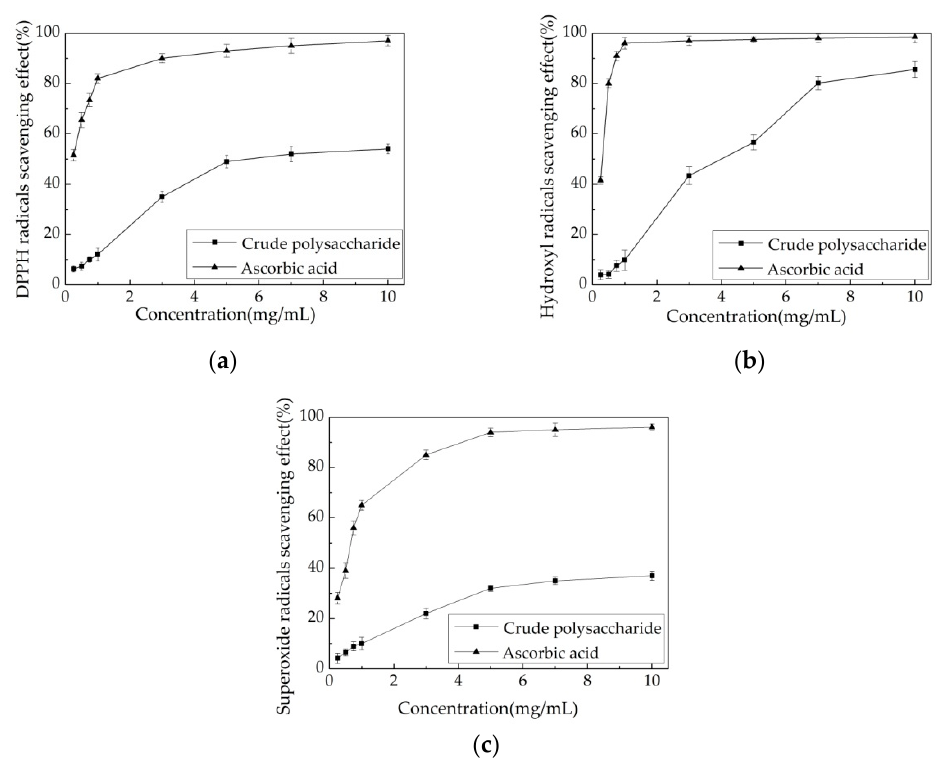
Figure 4. Antioxidant activities of Chlorella -Arc polysaccharides. ( a ) Scavenging effects on DPPH radical. ( b ) Scavenging effects on hydroxyl radical. ( c ) Scavenging effects on superoxide radical. Errors bars represent standard errors from three replicates. Table 3. Antioxidant activity of Chlorella -Arc polysaccharides at 5.0 mg/mL.